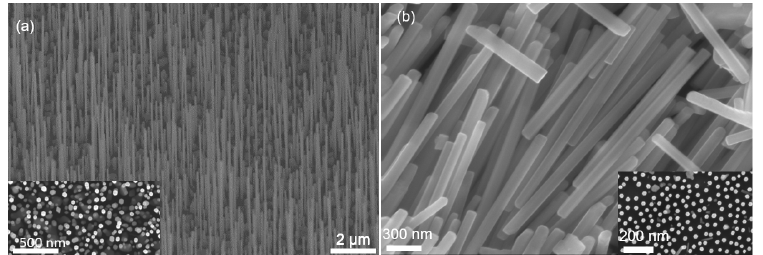
Figure 1. SEM micrograph of catalyst-free selective area InAs nanowires, ( a ) top view (inset) and 30 ◦ tilted view of zincblende nanowires, ( b ) top view (inset) of as-grown and mechanically placed wurtzite InAs nanowires on Si substrate for surface